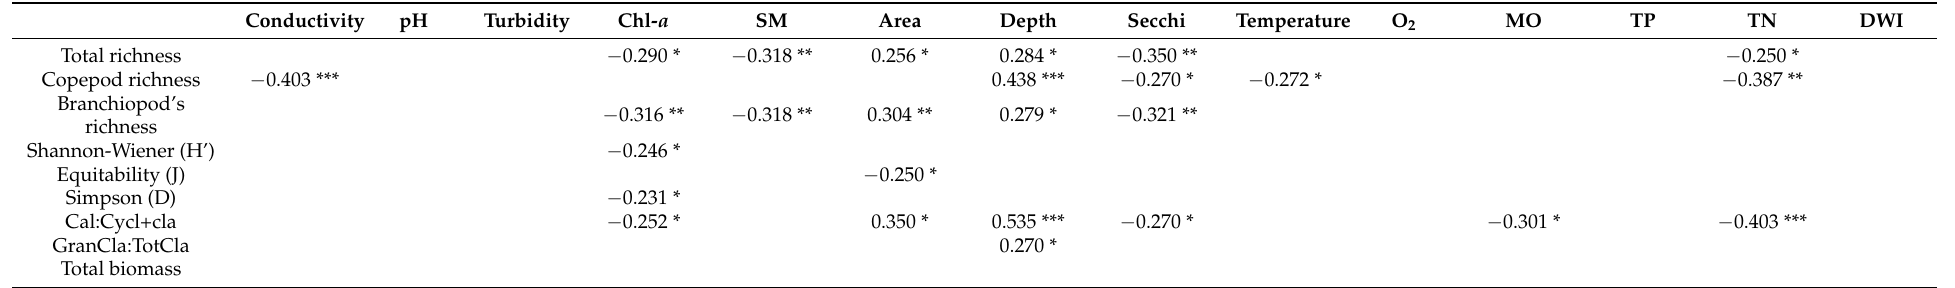
Table 4. Coefficients of the Spearman correlation among zooplankton parameters and environmental variables. * p < 0.05; ** p < 0.01; *** p <